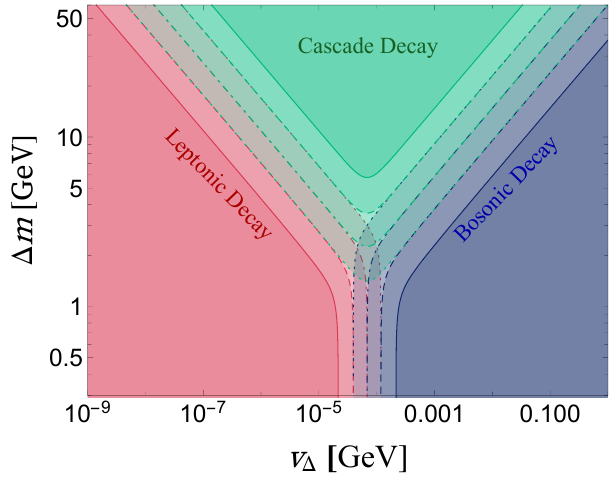
Figure 13 . Generic decay phase diagram for ∆ ±± in our model, with m dot-dashed, dashed and thick solid contours correspond to 99%, 90%, 50% and 10% branching ratios respectively for the leptonic, bosonic or cascade decays, whereas ∆ m is the mass splitting between the ∆ ++ and the next lightest scalar